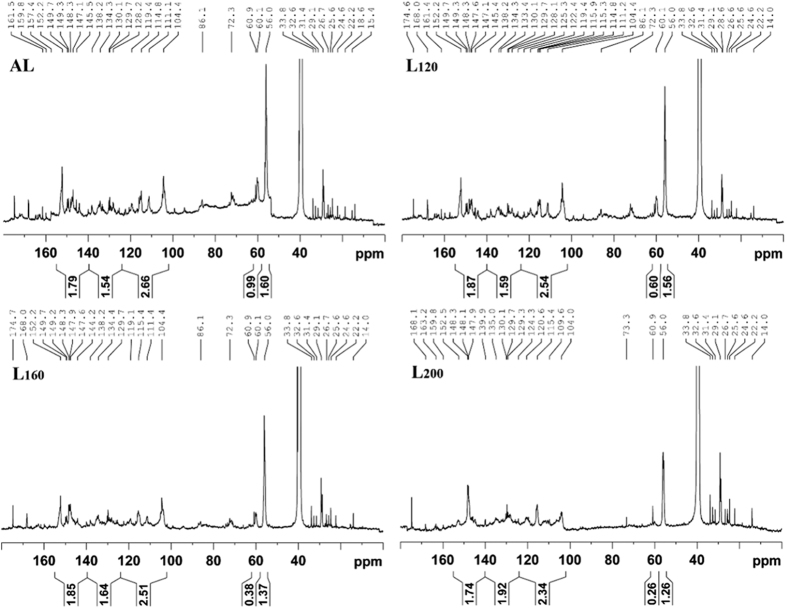
13C NMR spectra of the lignin fractions.